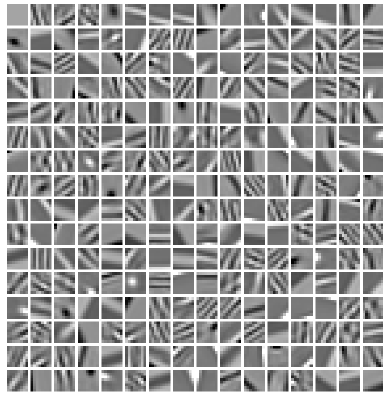
Figure 2. The dictionary trained using the chest image in Figure1.